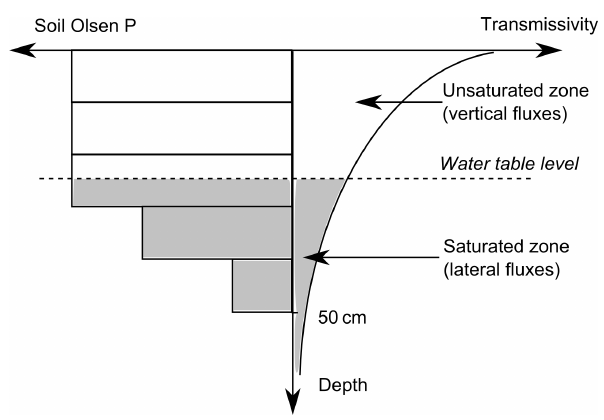
Figure 2. Description of soil hydraulic properties and phosphorus content with